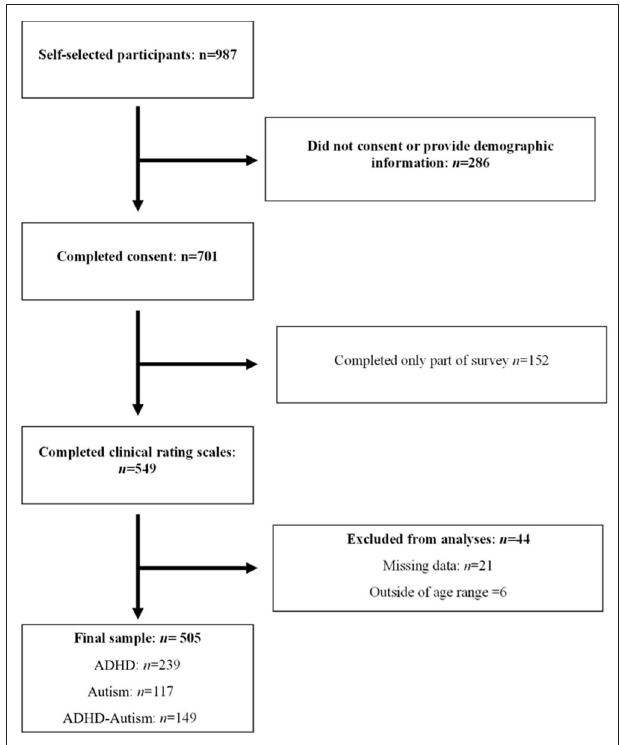
FIGURE 1 | Participant inclusion and exclusion